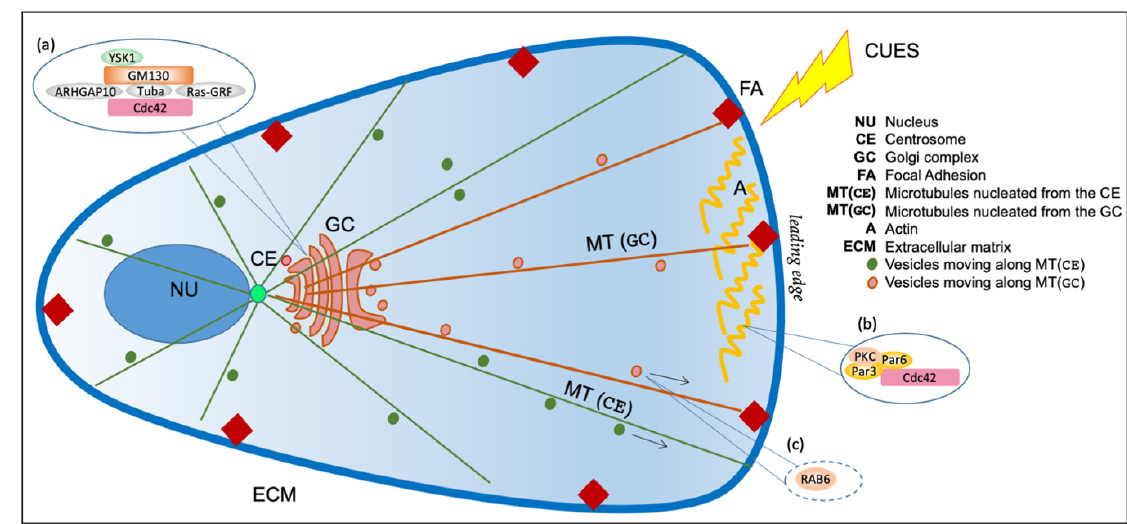
Figure 2. Schematic representation of Golgi complex with respect to the centrosome and nucleus. The Golgi complex (GC) is positioned near the centrosome (CE) in front of the nucleus (NU). The cytoskeleton comprises actin (A) and microtubules (MT). Actin controls membrane traffic and rigidity of the Golgi complex, while microtubules can be nucleated both from centrosome (CE) and Golgi (GC). The centrosome regulates the nucleation of a radial array of microtubules (green, MT (GC)) that maintain the pericentriolar localization of the Golgi Complex. The Golgi complex nucleates microtubules (brown, MT (GC)) asymmetrically oriented toward the leading edge. Insets ( a , b ) represent selected schematic depictions of protein complexes involved in polarized traffic localized at the Golgi complex ( a ) or at the plasma membrane ( b ); see the text for more details. Inset ( c ) shows a selected example of a crucial regulator of post-Golgi traffic, the small GTPases RAB6, which controls protein complexes involved directed secretion to hotspots closely associated with FAs, and that is also transported to FAs through MTs; see the text for more details.